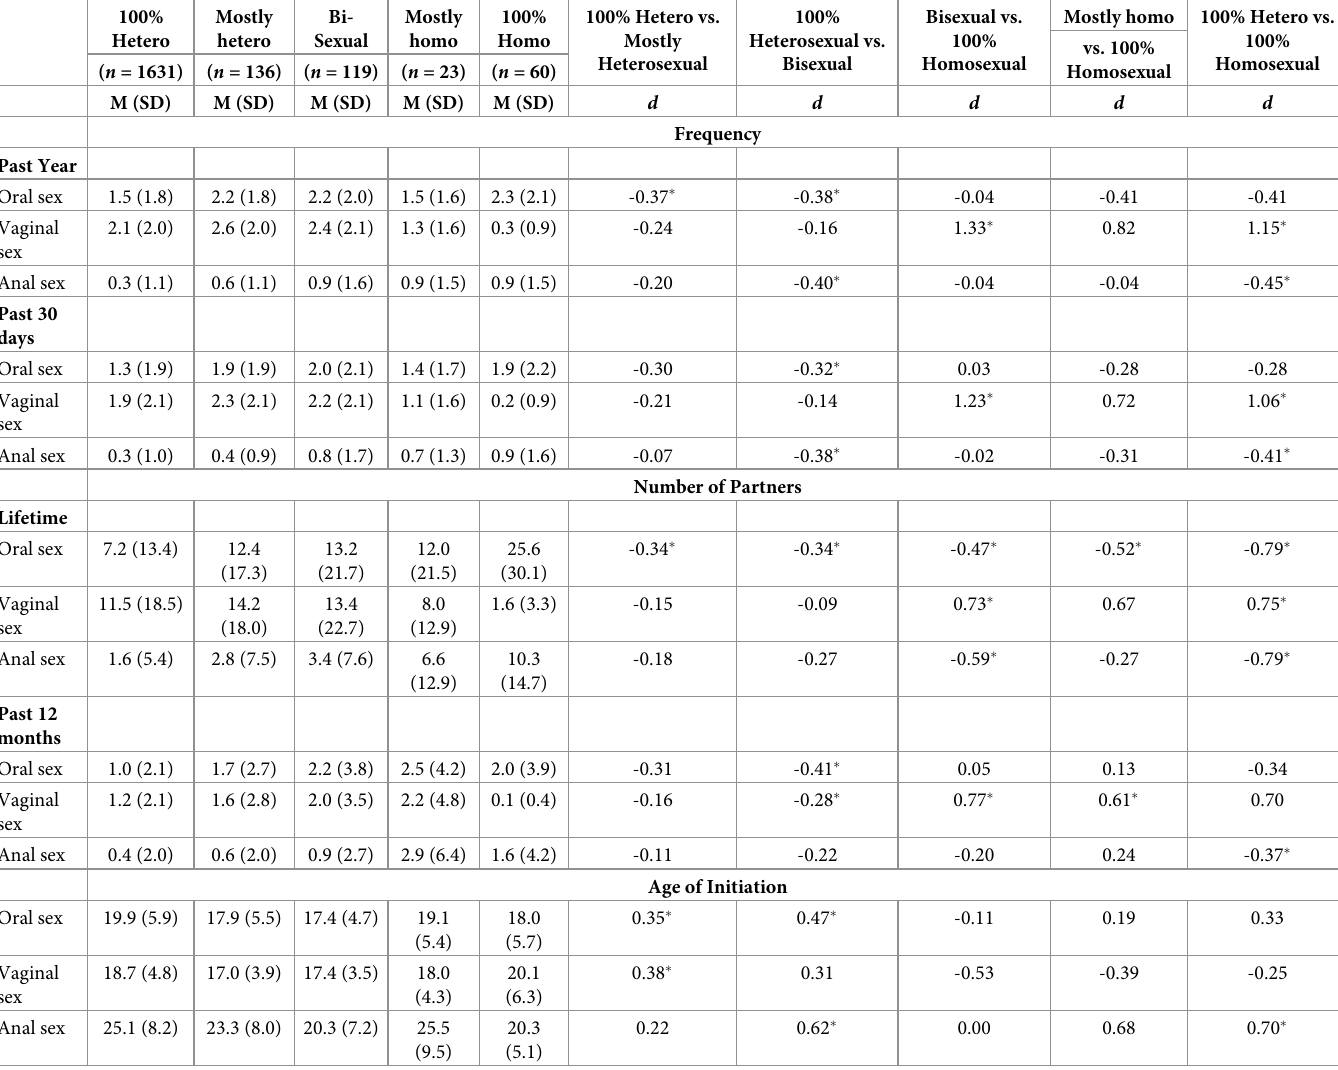
Table 7. Descriptive statistics and comparisons across sexual orientations for frequency, number of partners, and age of initiation of oral, vaginal, and anal sex. 100%